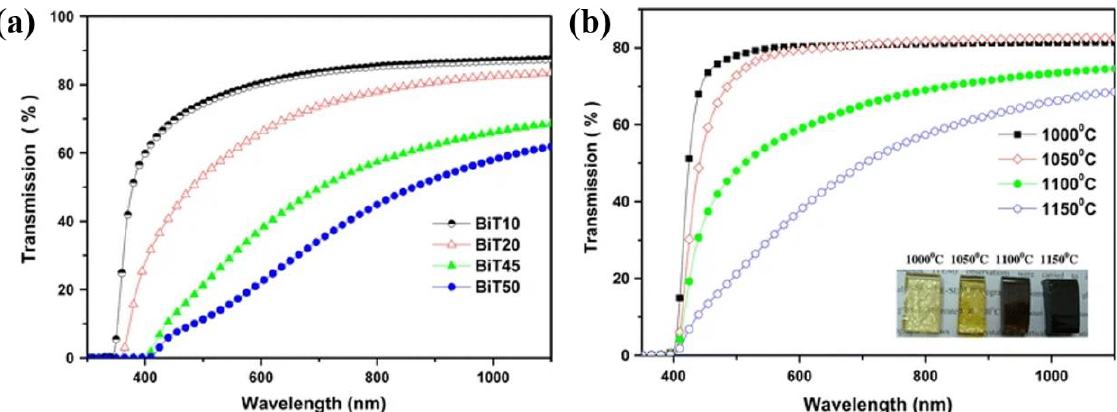
Figure 8. Transmission spectra of BiT glasses. ( a ) Transmission spectra of BiT10, BiT20, BiT45 and BiT50 glasses melted at 1150 °C. ( b ) Transmission spectra of BiT45 glasses melted at 1000, 1050, 1100 and 1150 °C. Inset is the photograph of the glasses showing their visual transparency. Reprinted with permission from Ref. [56].